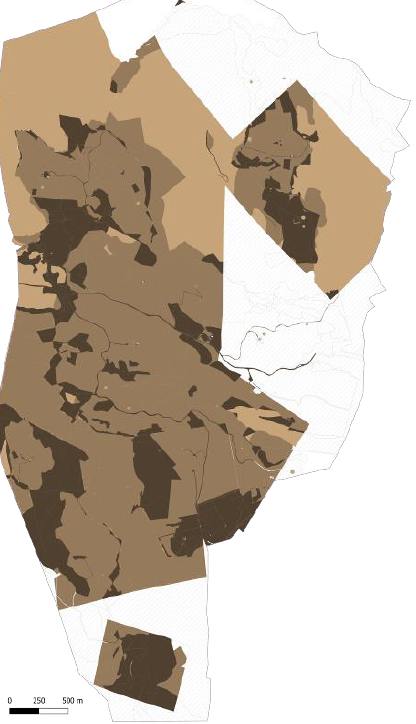
Figure 12 . Trajectories of landscape’s change: general overview mapping